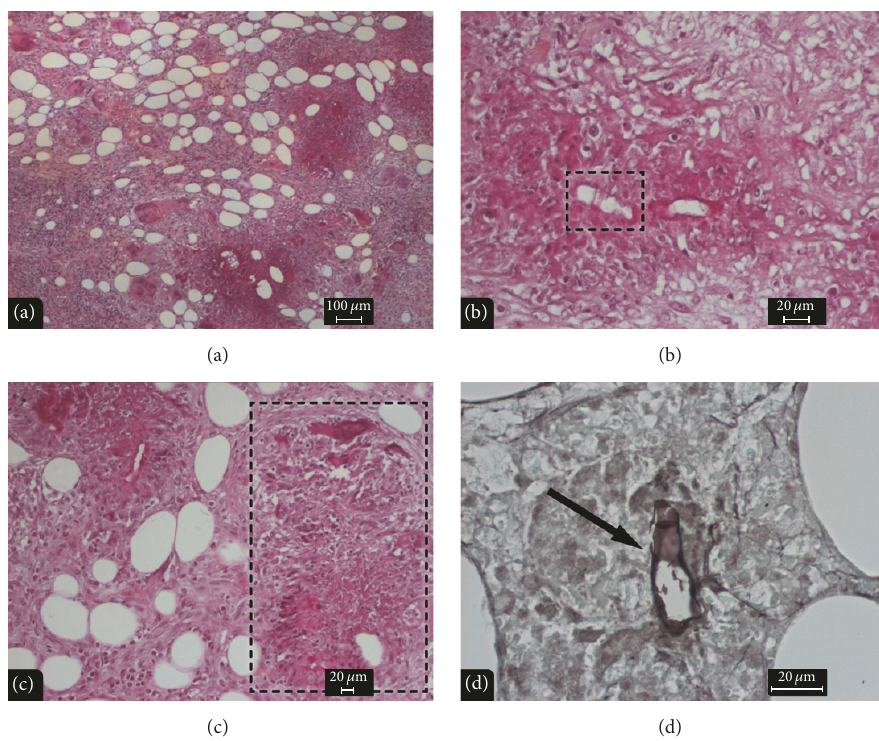
Figure 2: Histopathology of basidiobolomycosis. (a) Granulomatous inflammation with eosinophils and multinucleated giant cells in the subcutaneous tissue. Hematoxylin-Eosin, 50x. (b) Granulomatous inflammation with eosinophils cells and septate hyphal fragments. Hematoxylin-Eosin, 100x. (c) Granulomatous inflammation with eosinophils, multinucleated giant cells, and the Splendore-Hoeppli phenomenon. Hematoxylin-Eosin, 100x. (d) Septate hyphal fragments (arrow). Gomori-Grocott staining,